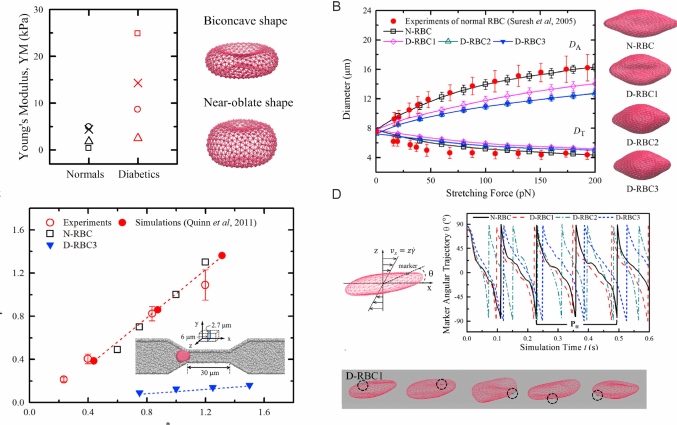
Figure 1. ( A ) Left: Young’s moduli of normal and diabetic RBCs reported from Fornal et al. [61] (crosses); Ciasca et al. [62] (triangles); Zhang et al. [63] (squares); Lekka et al. [64] (circles). Right: Particle-based models for RBCs with equilibrium biconcave ( A / V = 1.44) and near-oblate ( A / V = 1.04) shapes. ( B ) Comparison of stretching responses between normal and three T2DM RBC models. Experimental data by Suresh et al. [65], and stretching force at 100 pN are shown next to the figure. ( C ) Normal and diabetic RBC traversing velocities ( v ∗ ) in a microfluidic channel with a width of 6.0 µ M under difference pressure gradients ( (cid:52) P ). Experimental and simulation results from prior work of Quinn et al. [66] are plotted for comparison. ( D ) Tank-treading motion of normal and diabetic RBCs in Couette flow. Top: angular trajectories of marked particles on the cell membrane during the TT motion for different RBC models at a shear rate 105 s − 1 are plotted. Bottom: Snapshots of diabetic RBC model at time t = 0.20 s, 0.25 s, 0.30 s, 0.35 s, and 0.40 s. Figures are adopted from [58] with